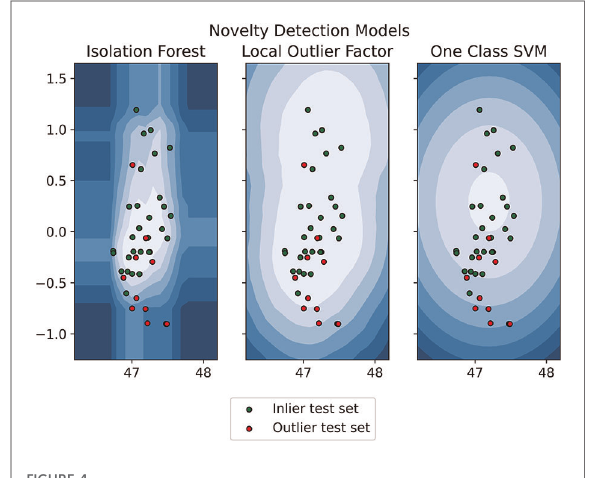
FIGURE 4 Model ’ s decision function in relation to the distribution of inlier and outlier test set